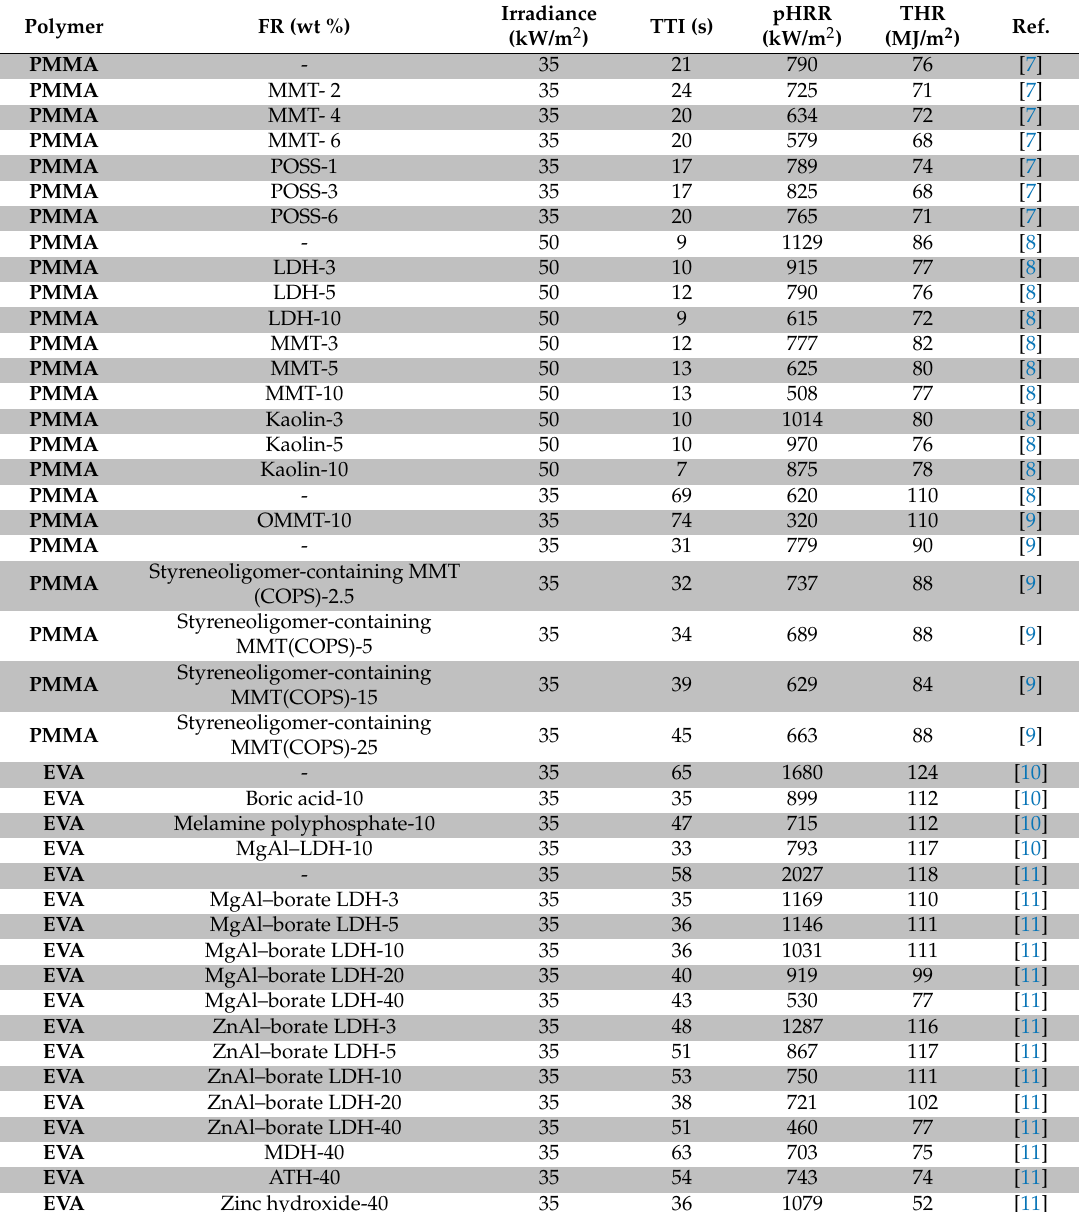
Table 1. Cone calorimetry data on pHRR, THR, and TTI characteristics of thermoplastic composites based on PP, PMMA, PLA, and EVA matrices components filled with a wide variety of additives. In the second column, the type and wt % of filler are typically represented as X-N denoting X type additive loaded with N wt % to the base